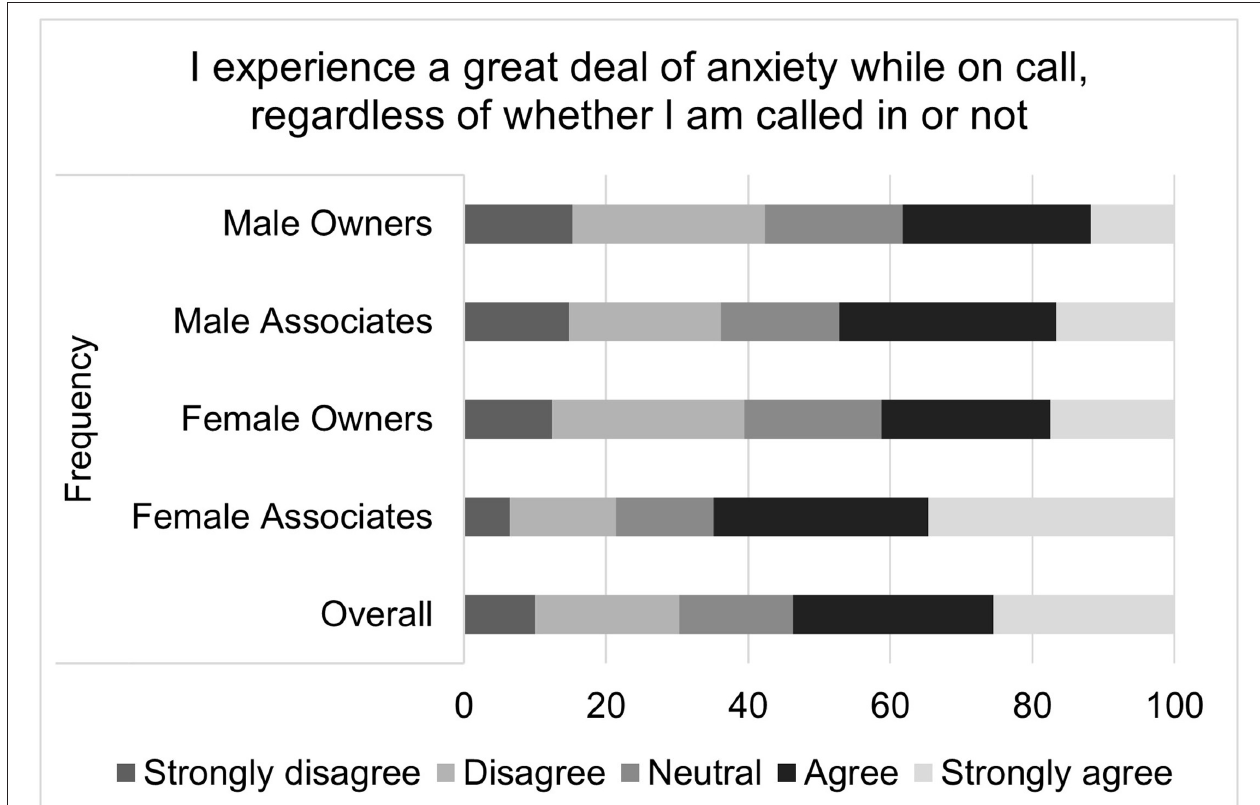
FIGURE 1 | Frequency of having to report to the work site vs. handle matters by phone, during on-call shifts.